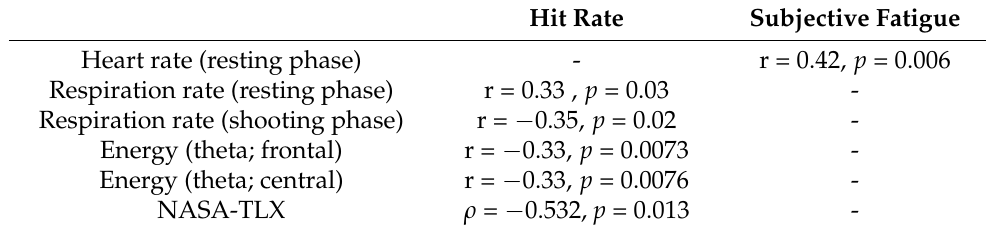
Table 1. The results of correlation